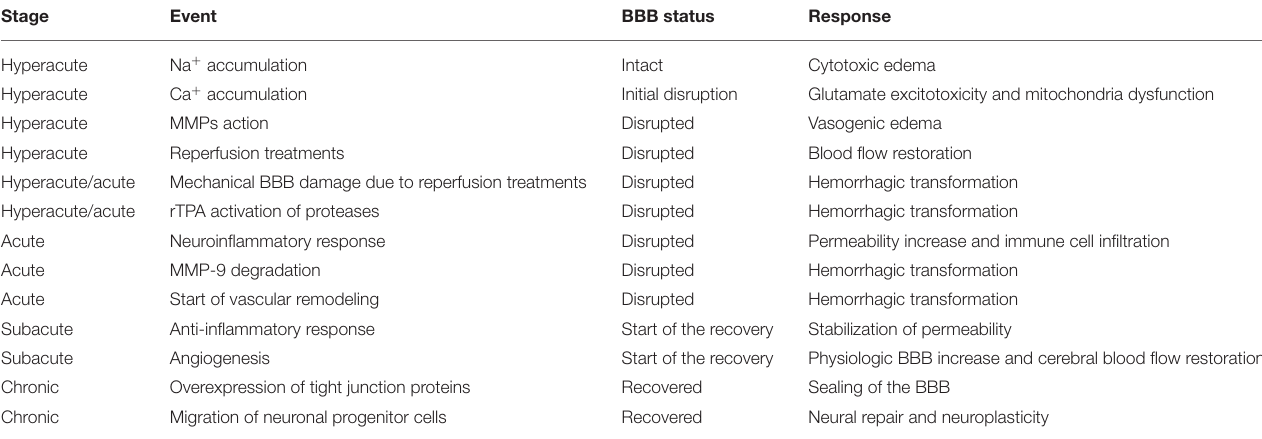
TABLE 2 | Main events driving blood–brain barrier (BBB) dynamics and hemorrhagic transformation after